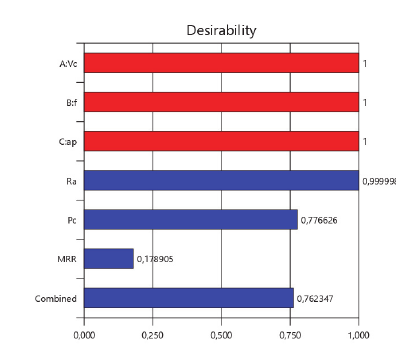
Fig. 31. Bar graph of desirability for combined